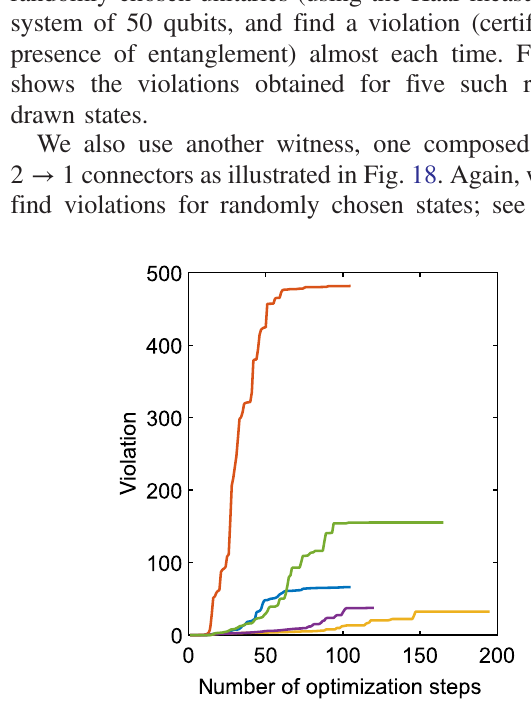
FIG. 19. Entanglement detection in FCS mixed states of 60 qubits using 2 → 1 connectors. We randomly sample five states and find a violation in each case. Each optimization step consists of optimizing one connector. We find much larger violations than when using 2 → 2